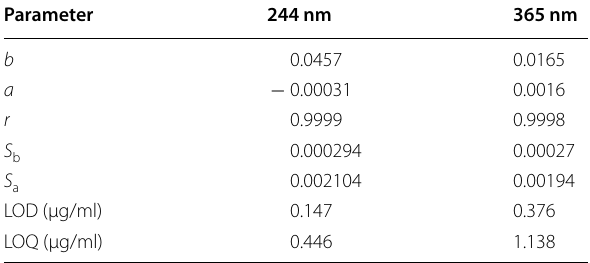
b slope, a intercept, r correlation coefficient, S b standard deviation of the slope, S